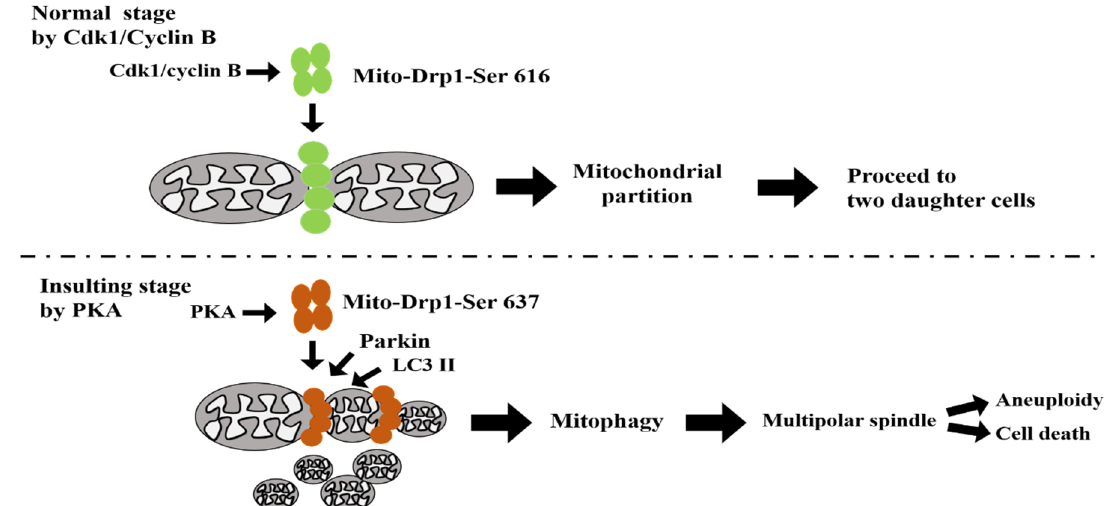
Figure 8. Model of cross-talk between mitochondrial ETC proteins and centrosomal kinases/proteins for centrosome function and bipolar spindles assembly. After nocodazole treatment, at M phase four inhibitors (two ETC inhibitors, ROT and AA; two Drp1 inhibitors; Mdivi-1 and Dynasore) were added to induce mitochondrial dynamic imbalance. AKAP1 is believed to be a scaffold protein that recruits PKA to modulate mitochondrial function at Drp1-Ser637 (also see supplementary Figure S8). In summary, upon normal conditions, during mitosis mitochondria are fragmented to facilitate segregation of this organelle to daughter cells. Mitochondrial fission is mediated by Cdk1-dependent phosphorylation and activation of Drp1-Ser616 [39]. Proper partitioning of mitochondria is required for inheritance during cell division, and then proceeds to the next cell cycle. However, upon inhibitor insulting conditions, mito-Drp1-Ser637 drives mitophagy via activated PKA during mitotic arrest. Dynamic Drp1-Ser637/Ser616 ratio affects the PINK1/Parkin pathway and promotes more efficient mitophagy while inducing multipolar spindles formation simultaneously. It appears that mito-Drp1-Ser637 induces mitochondrial fission to drive mitophagy and induces multipolar spindles formation to cause cell aneuploidy or cell death.